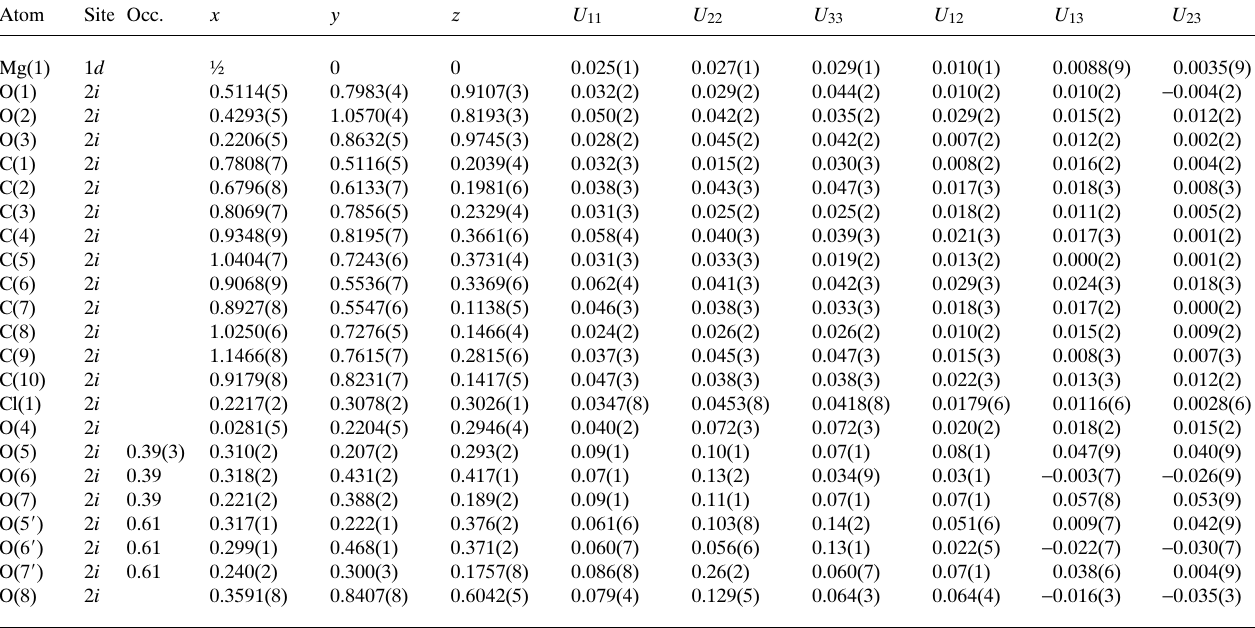
Table 3. Atomic coordinates and displacement parameters (in Å 2 ) . Atom Site